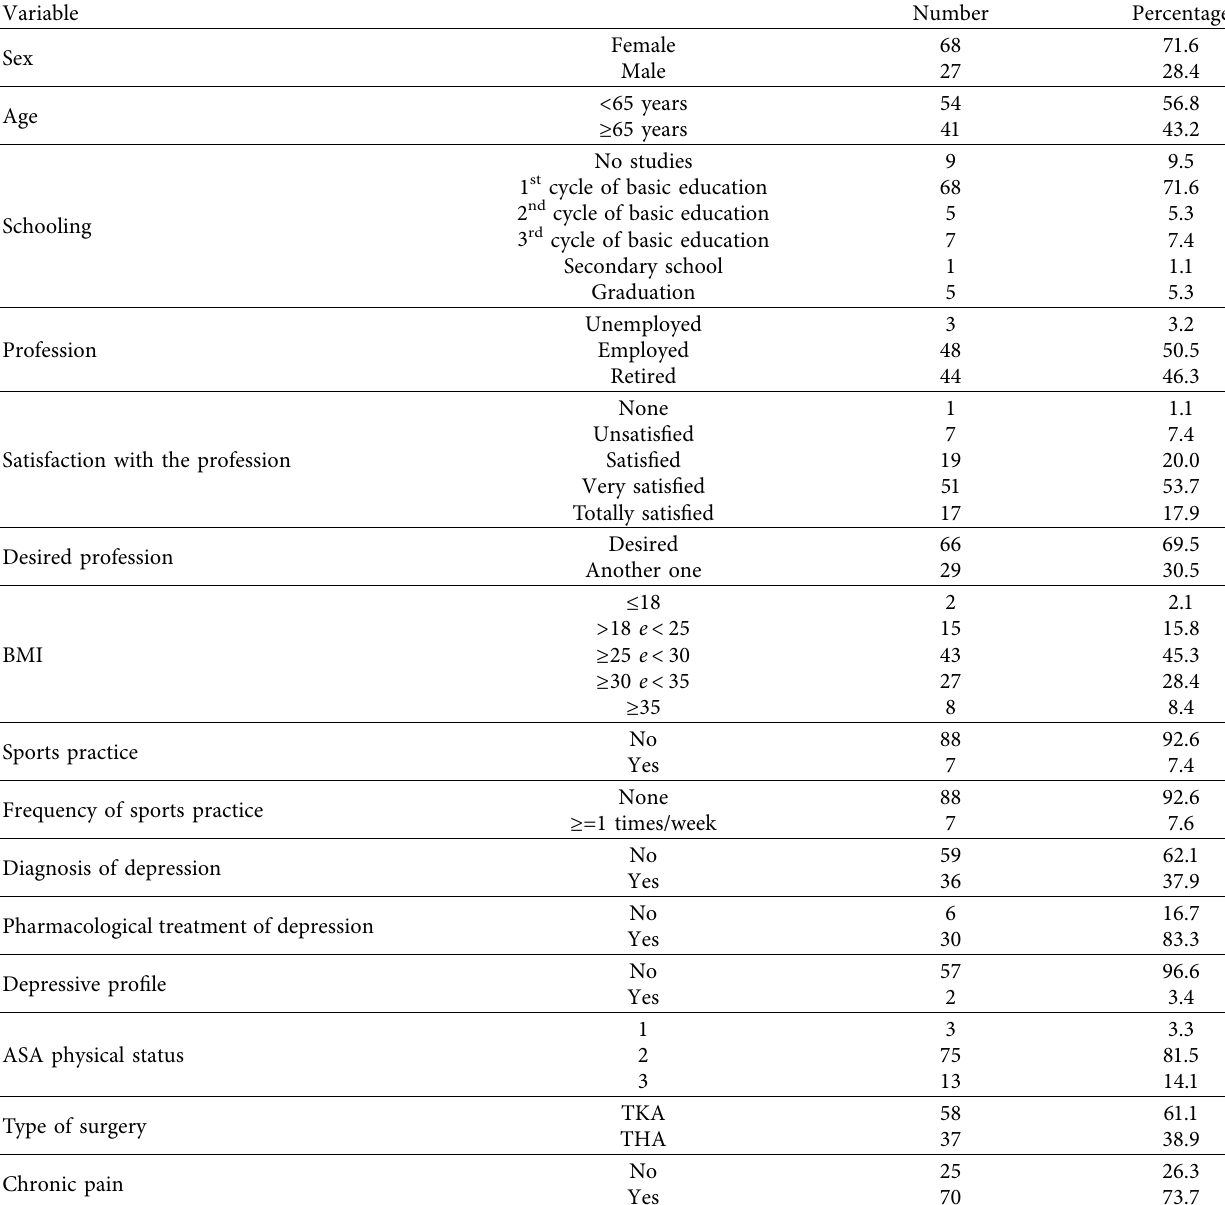
Table 1: Characterization of the study sample ( n �